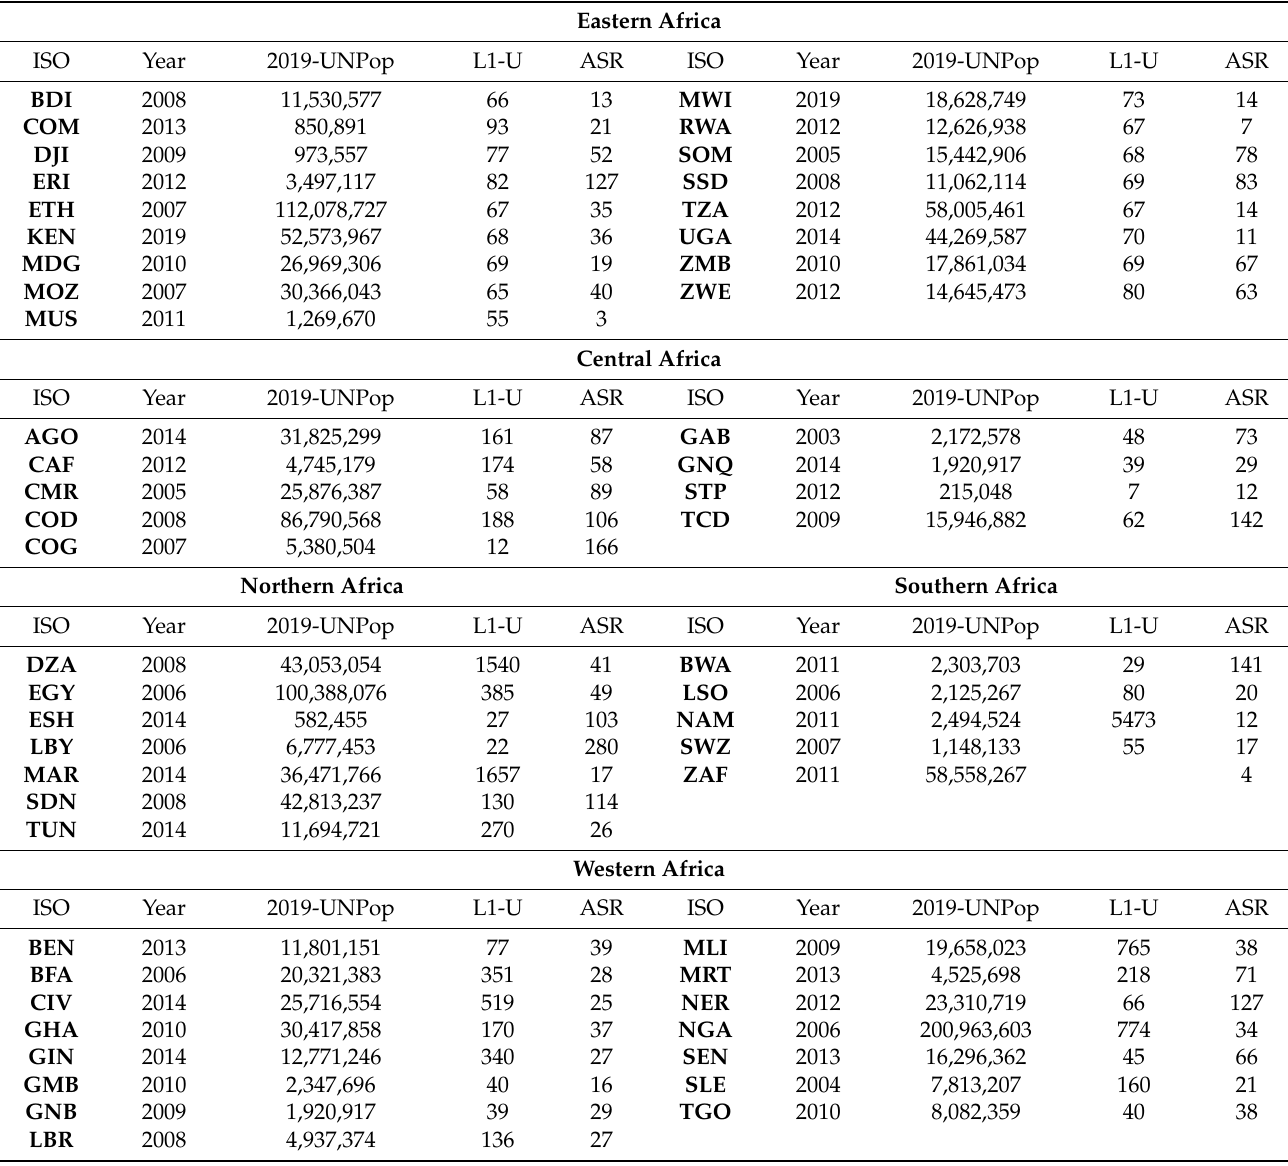
Table 1 shows a summary of the input population data. These include the three letter International Organisation for Standardization (ISO) identification code, total population for 2019 adjusted to the UN estimates, the base year of either the census or derived esti- mation, the number of subnational administrative units and the average spatial resolution (ASR) of the administrative units for each country. The data are presented divided in the five subregions according to the UN geoscheme for Africa [55]. Table 1. Summary of 2019 UN-adjusted subnational population census/estimate-based data (2019-UNPop) for each African country: 3 letter ISO code, census or estimation year, number of L1-units (L1-U), and the average spatial resolution (ASR). ASR represents the effective resolution of the L1-units in km, calculated as the square root of each country’s total area divided by the number of